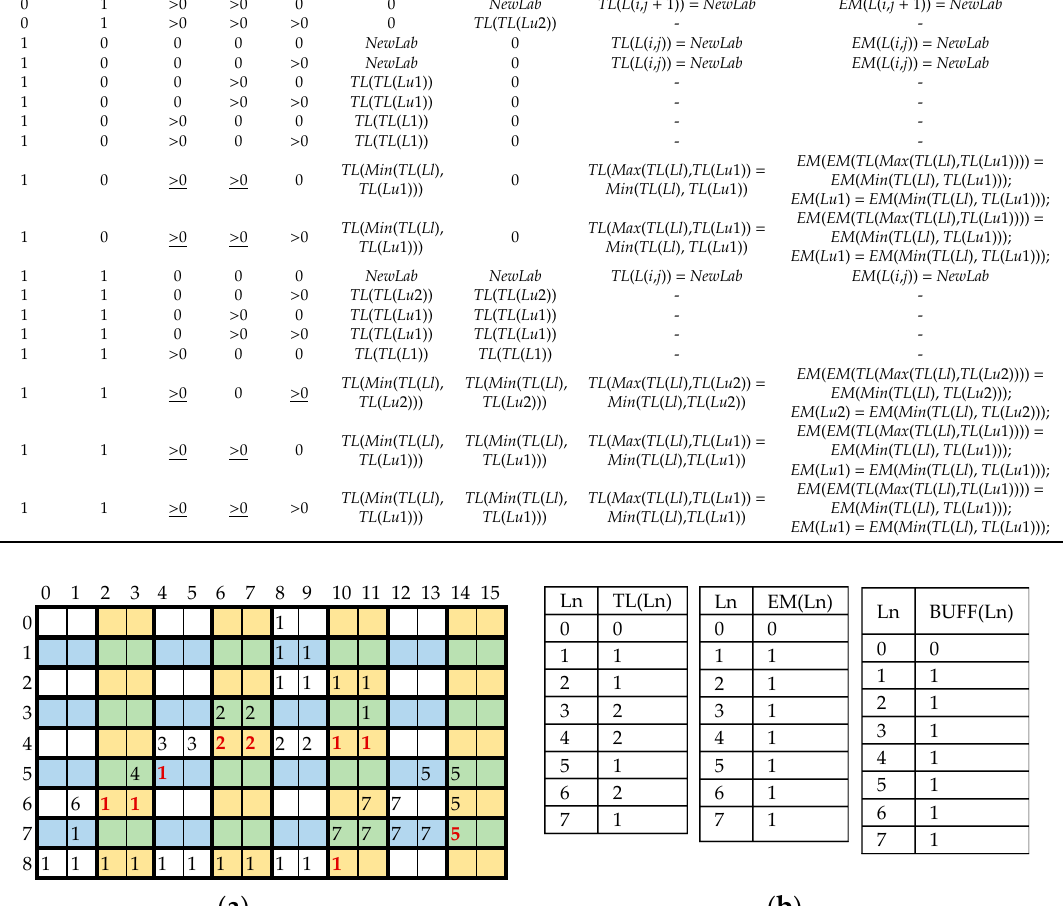
( b ) Figure 7. Example of parallel CCL: ( a ) the provisionally labeled image; ( b ) content of TL, EM, and BUFF.